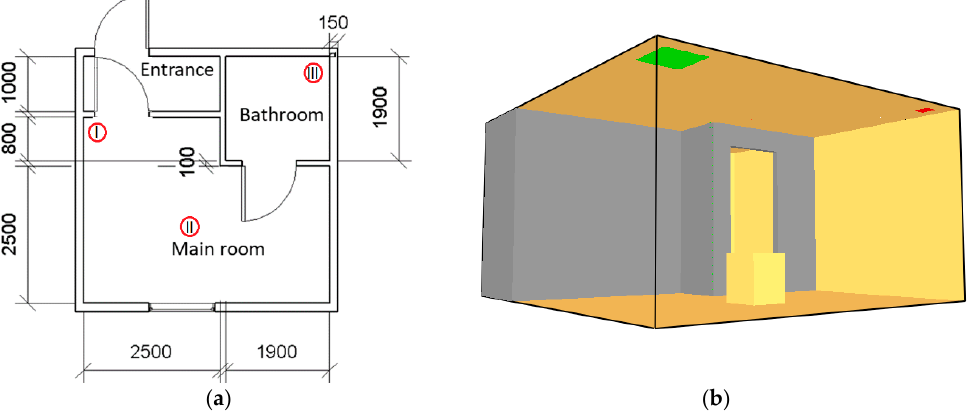
Figure 2. ( a ) Test room layout (unit: mm) and ( b ) the corresponding simulation model.